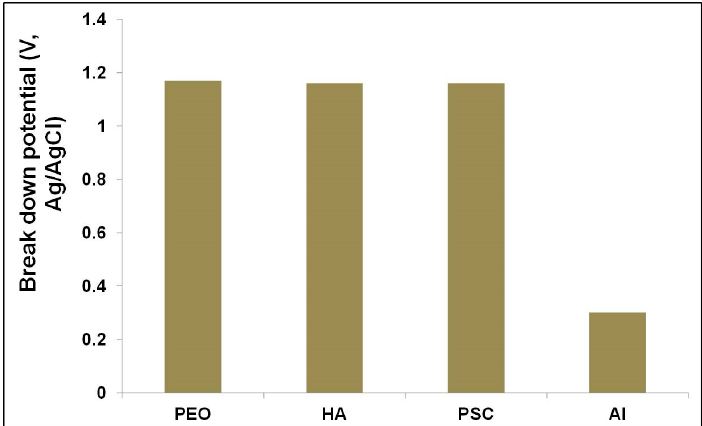
Figure 9. Comparison of breakdown potential from AP measurements for the tested materials against the Ag/AgCl reference